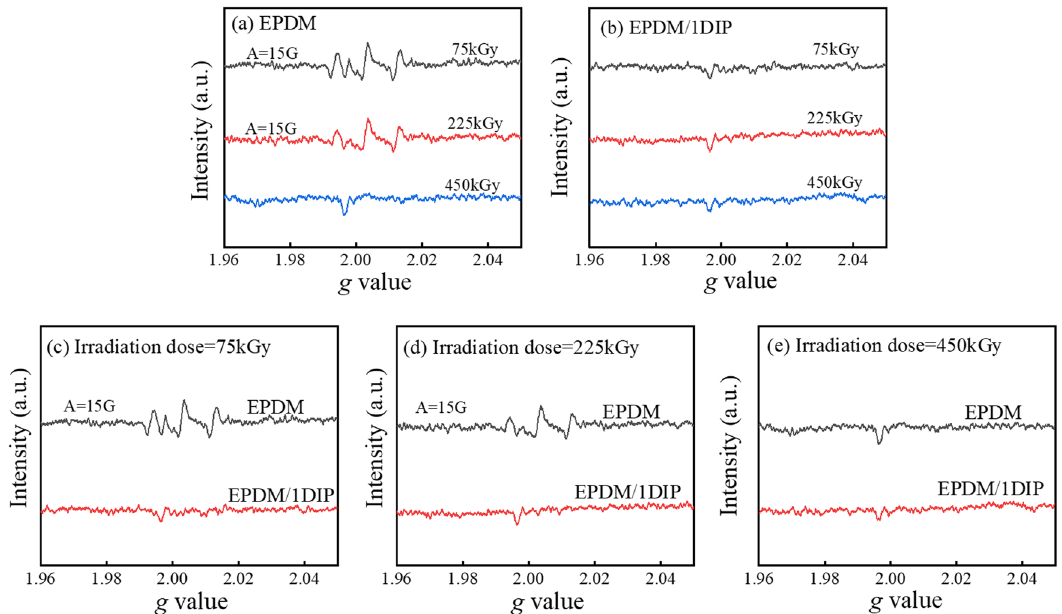
Fig. 4 ESR curves of the EPDM and EPDM/1DIP blend at different γ -irradiation doses. a ESR curves of the EPDM at the indicated irradiation doses, b ESR curves of the EPDM/1DIP blend at the indicated irradiation dose; c ESR curves of the EPDM and EPDM/1DIP blend at an irradiation dose of 75 kGy; d ESR curves of the EPDM and EPDM/1DIP blend at an irradiation dose of 225 kGy; e ESR curves of the EPDM and EPDM/1DIP blend at an irradiation dose of 450